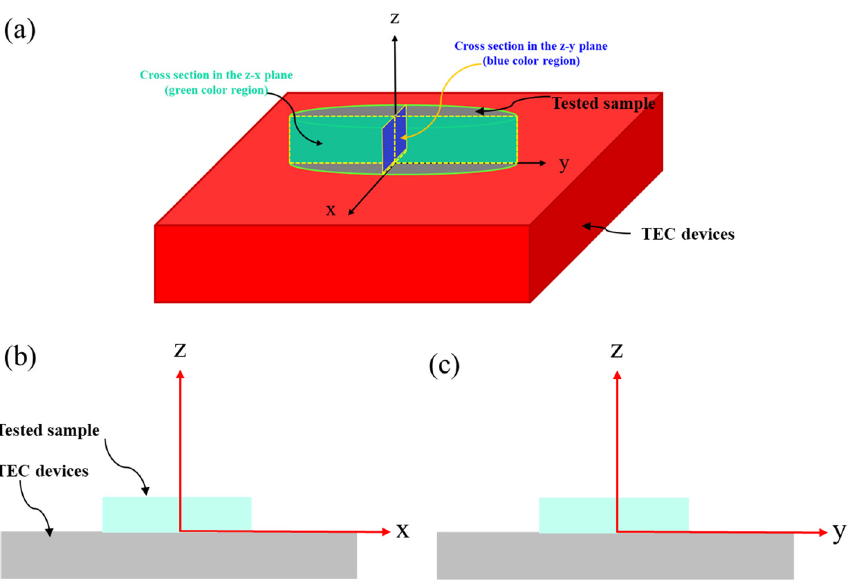
Figure 5. ( a ) A 3D view of the sample and the TEC illustrating the symmetry property of the sample and ( b ) the cross-section at the plane of z–x and ( c ) the plane of z–y.